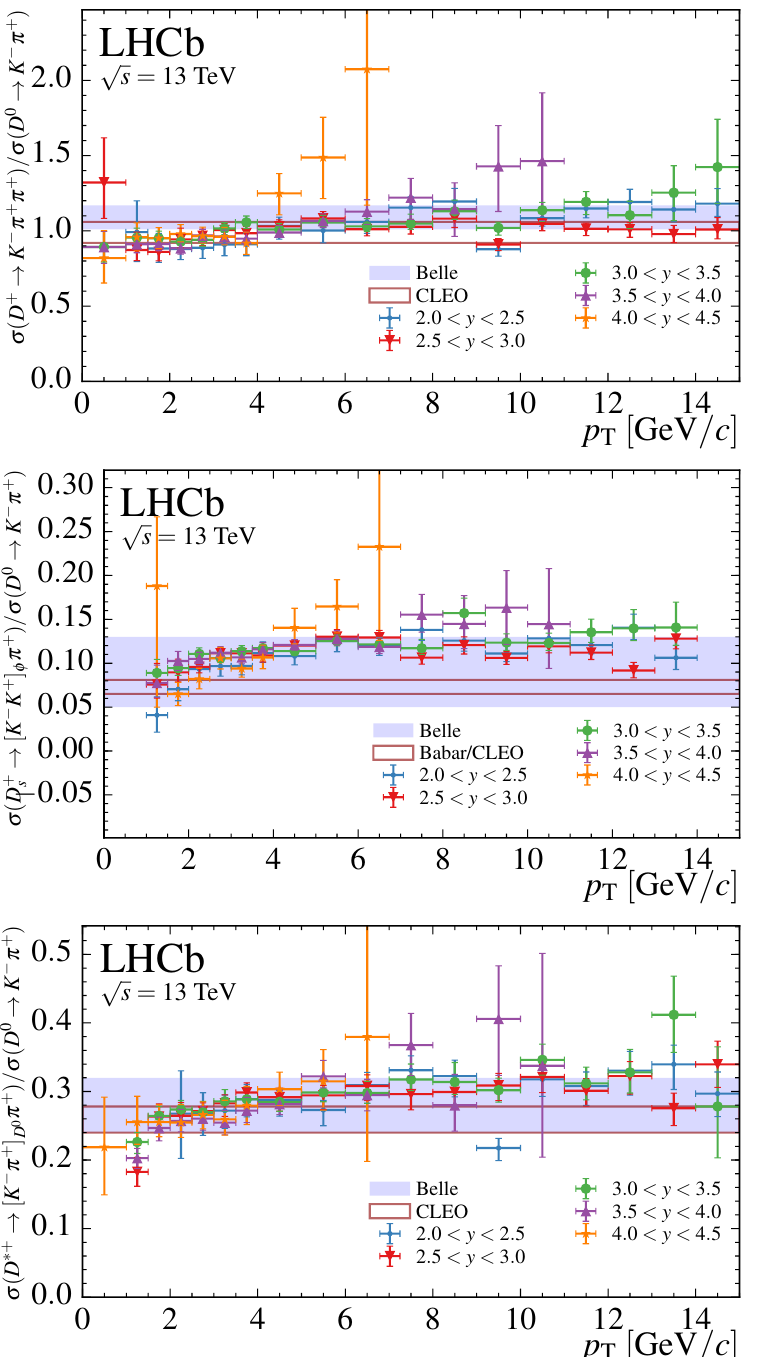
Figure 8. Ratios of cross-section-times-branching-fraction measurements of (top) D + , (middle) D + , and (bottom) D (cid:3) + mesons with respect to the D 0 measurements. The bands indicate the s corresponding ratios computed using measurements from e + e (cid:0) collider experiments [39{41]. The ratios are given as a function of p T and di(cid:11)erent symbols indicate di(cid:11)erent ranges in y . The notation (cid:27) ( D f ) is shorthand for (cid:27) ( D ) ( D f ). ! (cid:2) B !